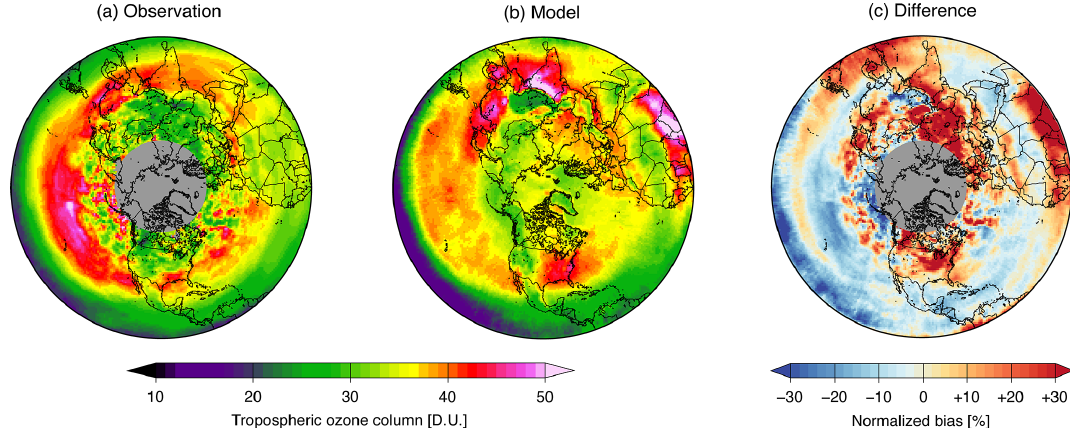
Figure 7. Tropospheric ozone column of (a) satellite observation, (b) H-CMAQ simulation, and (c) their differences shown as normalized bias. Areas filled in gray color indicate missing observations.